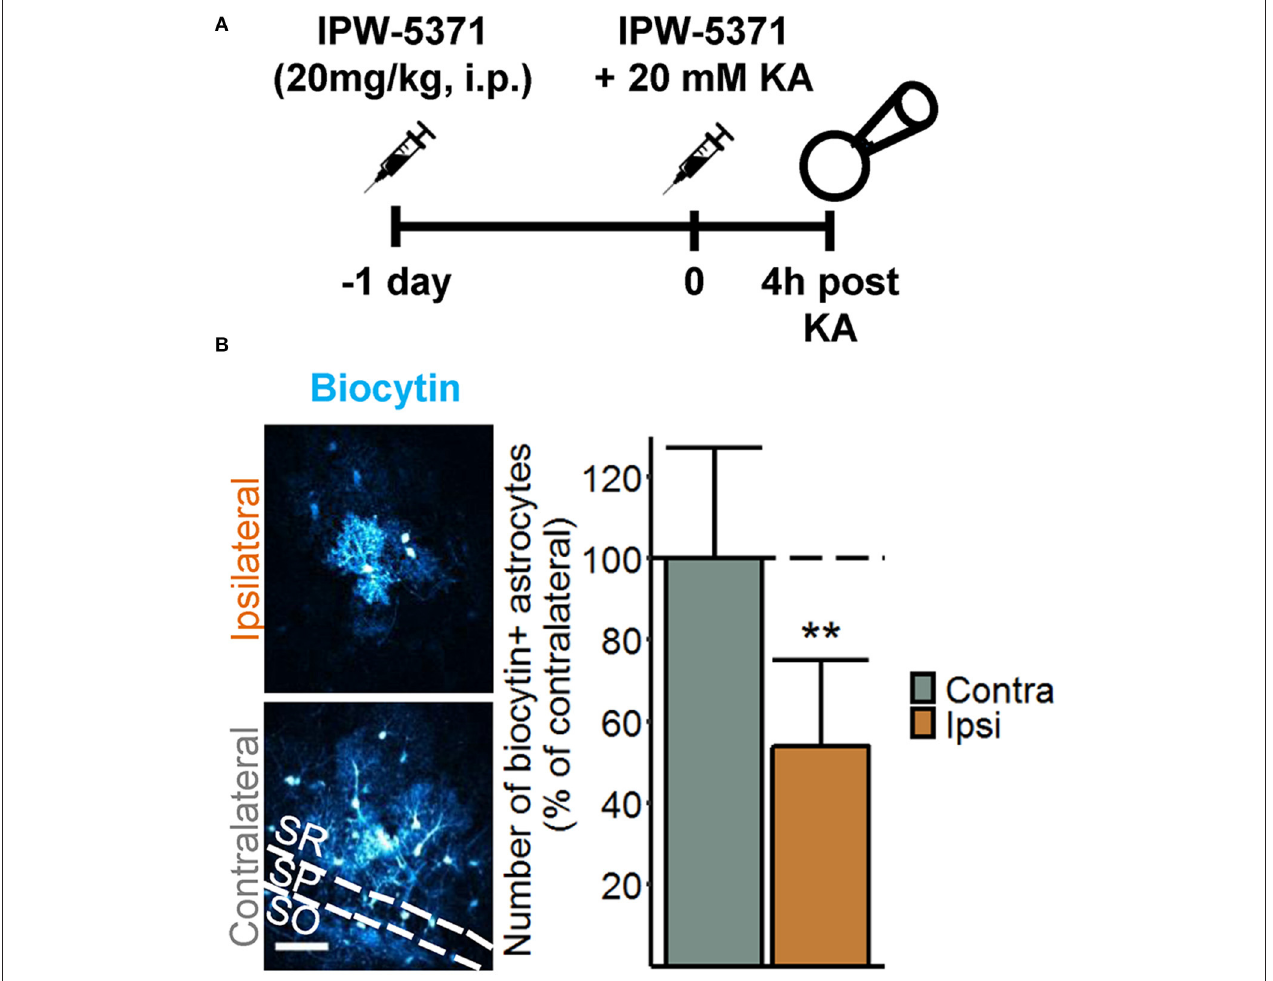
FIGURE 3 | Seizure-induced loss of astrocytic gap junctional communication is not mediated by TGFßR1 signaling. (A) Injection scheme for the biocytin diffusion studies. IPW-5371 was injected intraperitoneally (i.p.) once per day at 20 mg/kg for two consecutive days prior to SE induction via intracortical kainate injection. Four hours after kainate injection, animals were sacrificed and gap junctional coupling between hippocampal astrocytes was visualized by the intercellular spread of biocytin, which was included in the patch pipette solution during whole-cell patch clamp recordings (20min). (B) Representative maximum intensity projections depicting biocytin-filled astrocytes labeled with streptavidin-conjugated AlexaFluor® (AF) 647 in hippocampal CA1 stratum radiatum of the ipsi- and contralateral hemispheres ( left ). Scale bar: 50 µ m. The number of biocytin-positive astrocytes was significantly reduced on the ipsi- vs. contralateral hippocampus of IPW-5371-pretreated mice ( right ). Data represent mean ± SD. ** p < 0.01 (independent samples t -test). N = 9 slices/condition from three mice. KA, kainate; SR, stratum radiatum ; SP, stratum pyramidale ; SO, stratum oriens